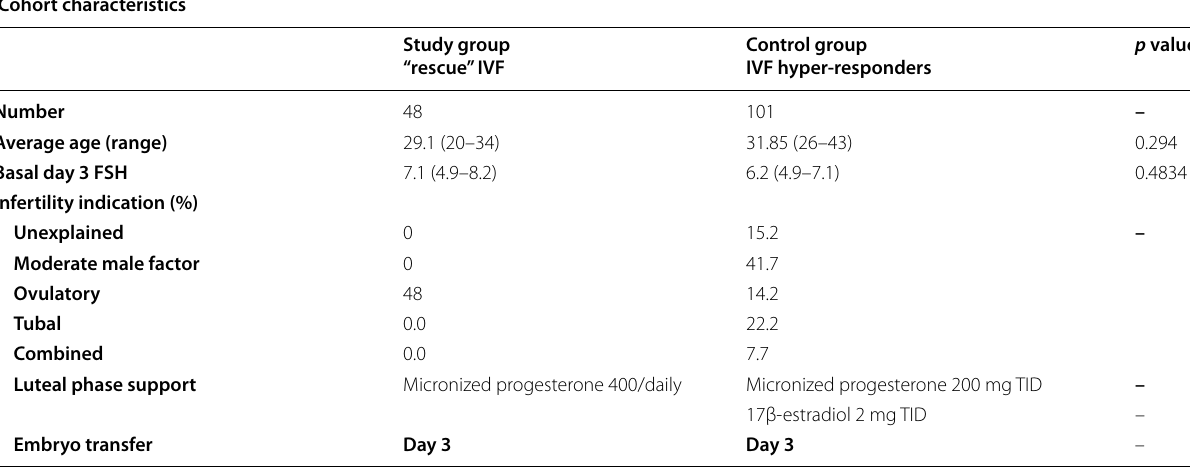
Table 4 Comparison of cohort characteristic rescue IVF with the control group of IVF hyper responders